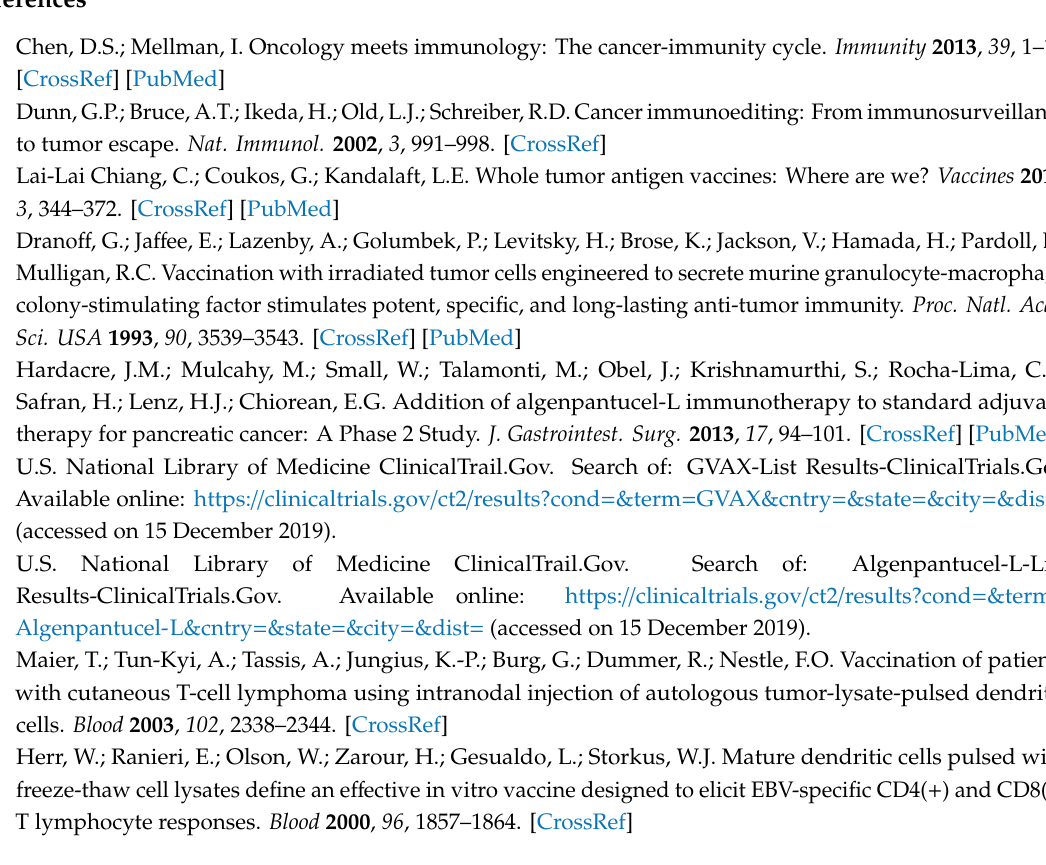
Figure S1: Pilot B16-F10 vaccination: Individual mouse tumor growth curves. Figure S2: Adjusted B16-F10 vaccination: individual mouse tumor growth curves. Figure S3: Adjusted CT26 vaccination: Individual mouse tumor growth curves. Figure S4: Example of delayed type hypersensitivity-like reaction at the vaccination site. Figure S5: B16-F10 and CT26 preventative vaccination: tumor growth curves. Figure S6: Adjusted B16-F10 and CT26 vaccination: H&E stained vaccination